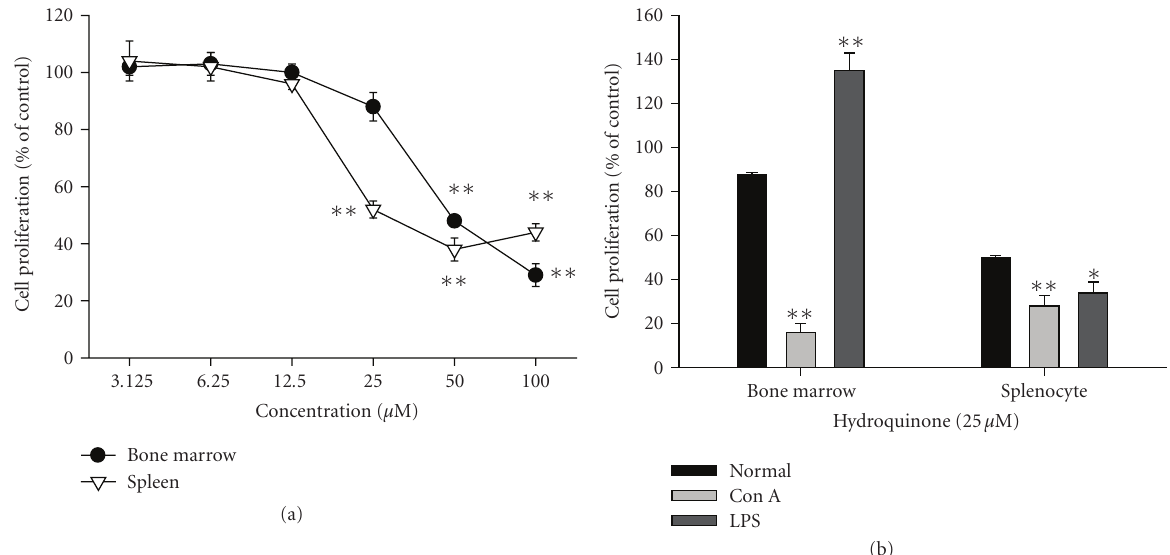
Figure 9: E ff ect of hydroquinone on the viablility or proliferation of splenic and bone marrow-derived lymphocytes induced by Con A and LPS. (a) Splenic lymphocytes (5 × 10 6 cells/mL) were incubated with hydroquinone under normal culture conditions. (b) Bone marrow-derived lymphocytes (5 × 10 6 cells/mL) were incubated with hydroquinone in the presence or absence of Con A (1 μ g/mL) and LPS (10 μ g/mL). Cell viability or proliferation was determined by MTT assay. ∗ p < . 05 and ∗∗ p < . 01 represent significant di ff erence as compared to normal or control.